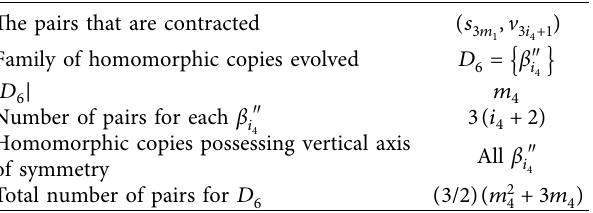
Table 5: Necessary information regarding homomorphic copies ″ 􏽮 β i 4